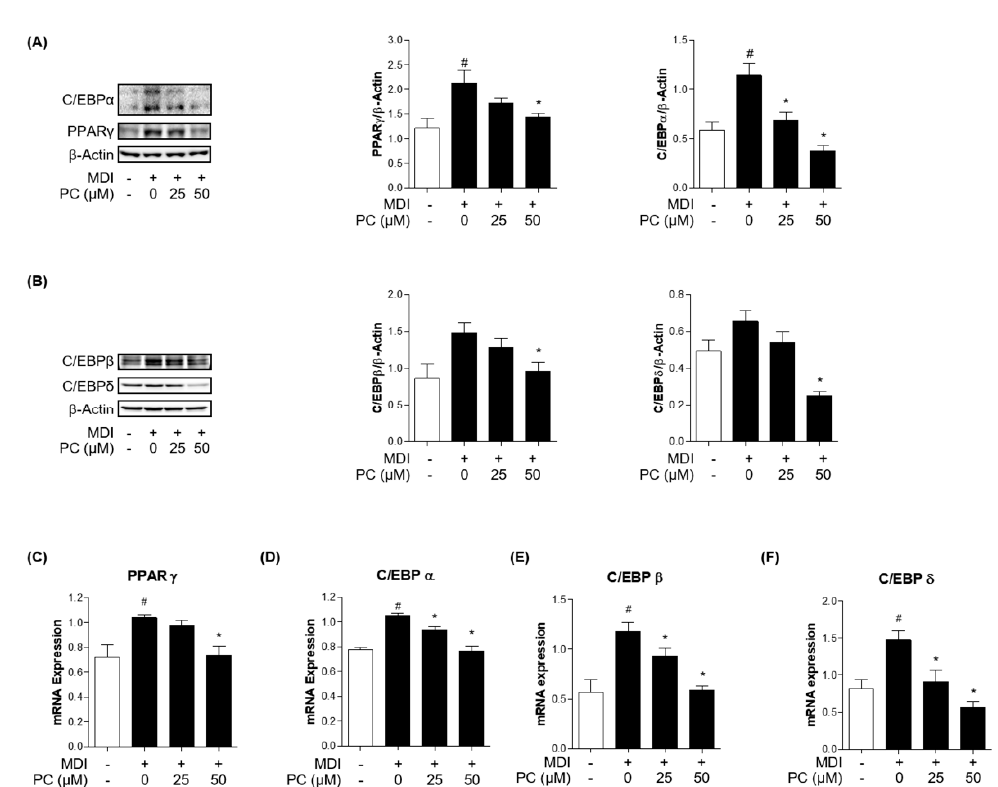
Figure 2. PC suppression of adipogenic factor expression levels in 3T3-L1 adipocytes: Cells were treated with MDI without or with PC. The protein levels of adipogenesis-related transcription factors were detected by Western blotting ( A , B ), and mRNA levels were detected by real-time PCR ( C – F ); The experimental data were obtained from at least three independent experiments and shown as means ± standard errors of the means. # p < 0.05 compared to the control (non-treated) group. * p < 0.05 compared to the MDI-treated group.